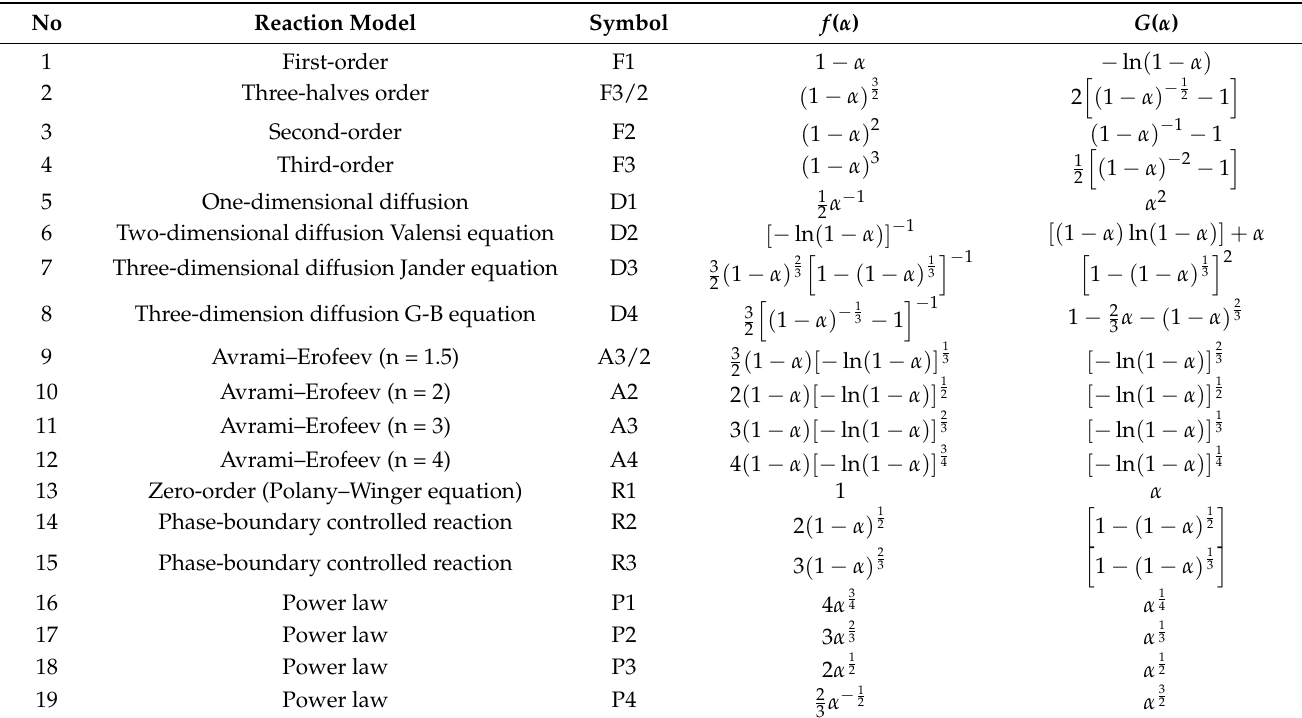
Table 2. Commonly-used classical reaction models applied to describe the pyrolysis process of